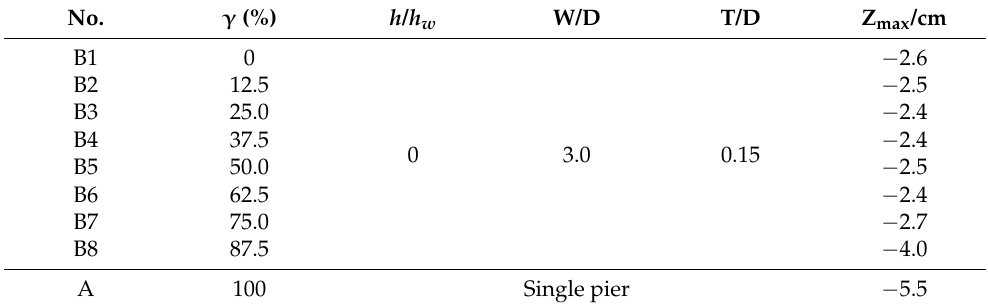
Table 2. Maximum local scour depth around the pier using a permeable collar with different porosities. No.